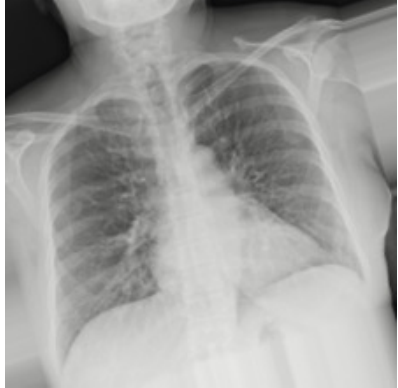
Figure 4. Geometric augmentation on X-ray from [8].